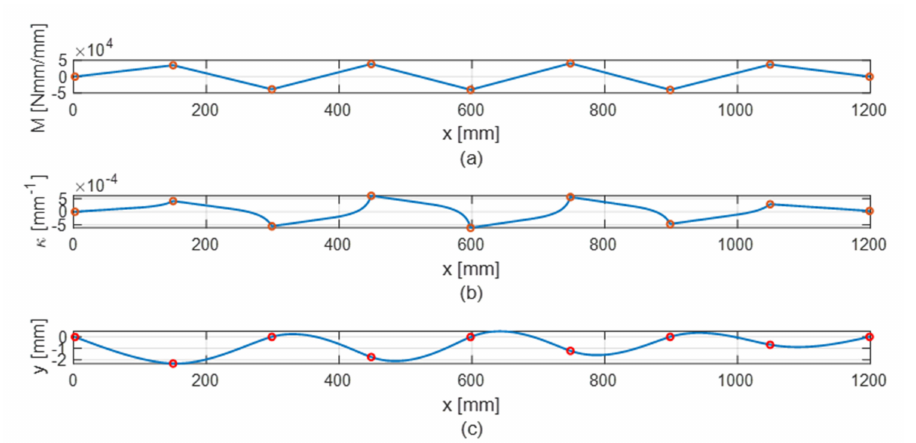
Figure 8. The deformed strip between roll 1 and roll 9.